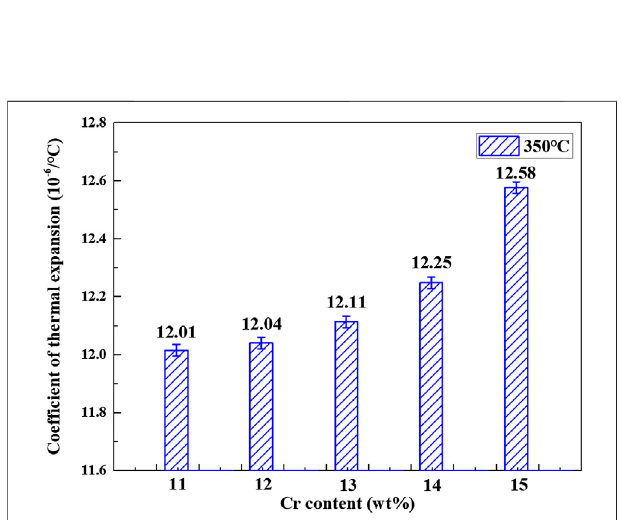
FIGURE 7 | Composition-density curves of Fe – x Cr – 6Al alloys with different Cr content. The density at 350 ° C is derived from the density of Fe – x Cr – 6Al alloys at 25 ° C and coef fi cient of thermal expansion at 350 ° C.